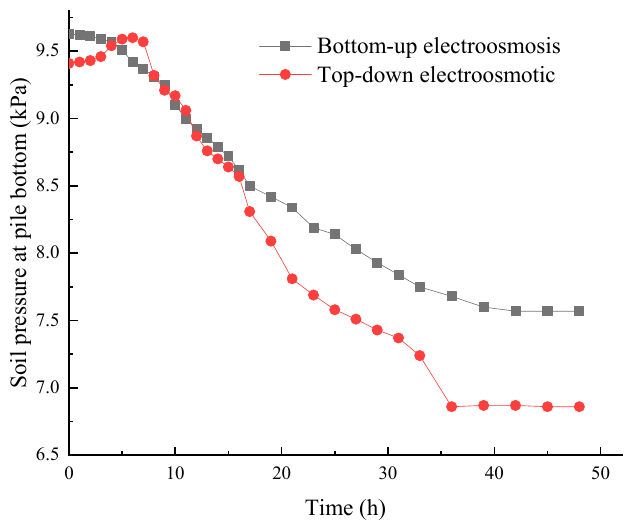
Figure 13. Variation curve of subsoil pressure of electro-osmosis pile with time.